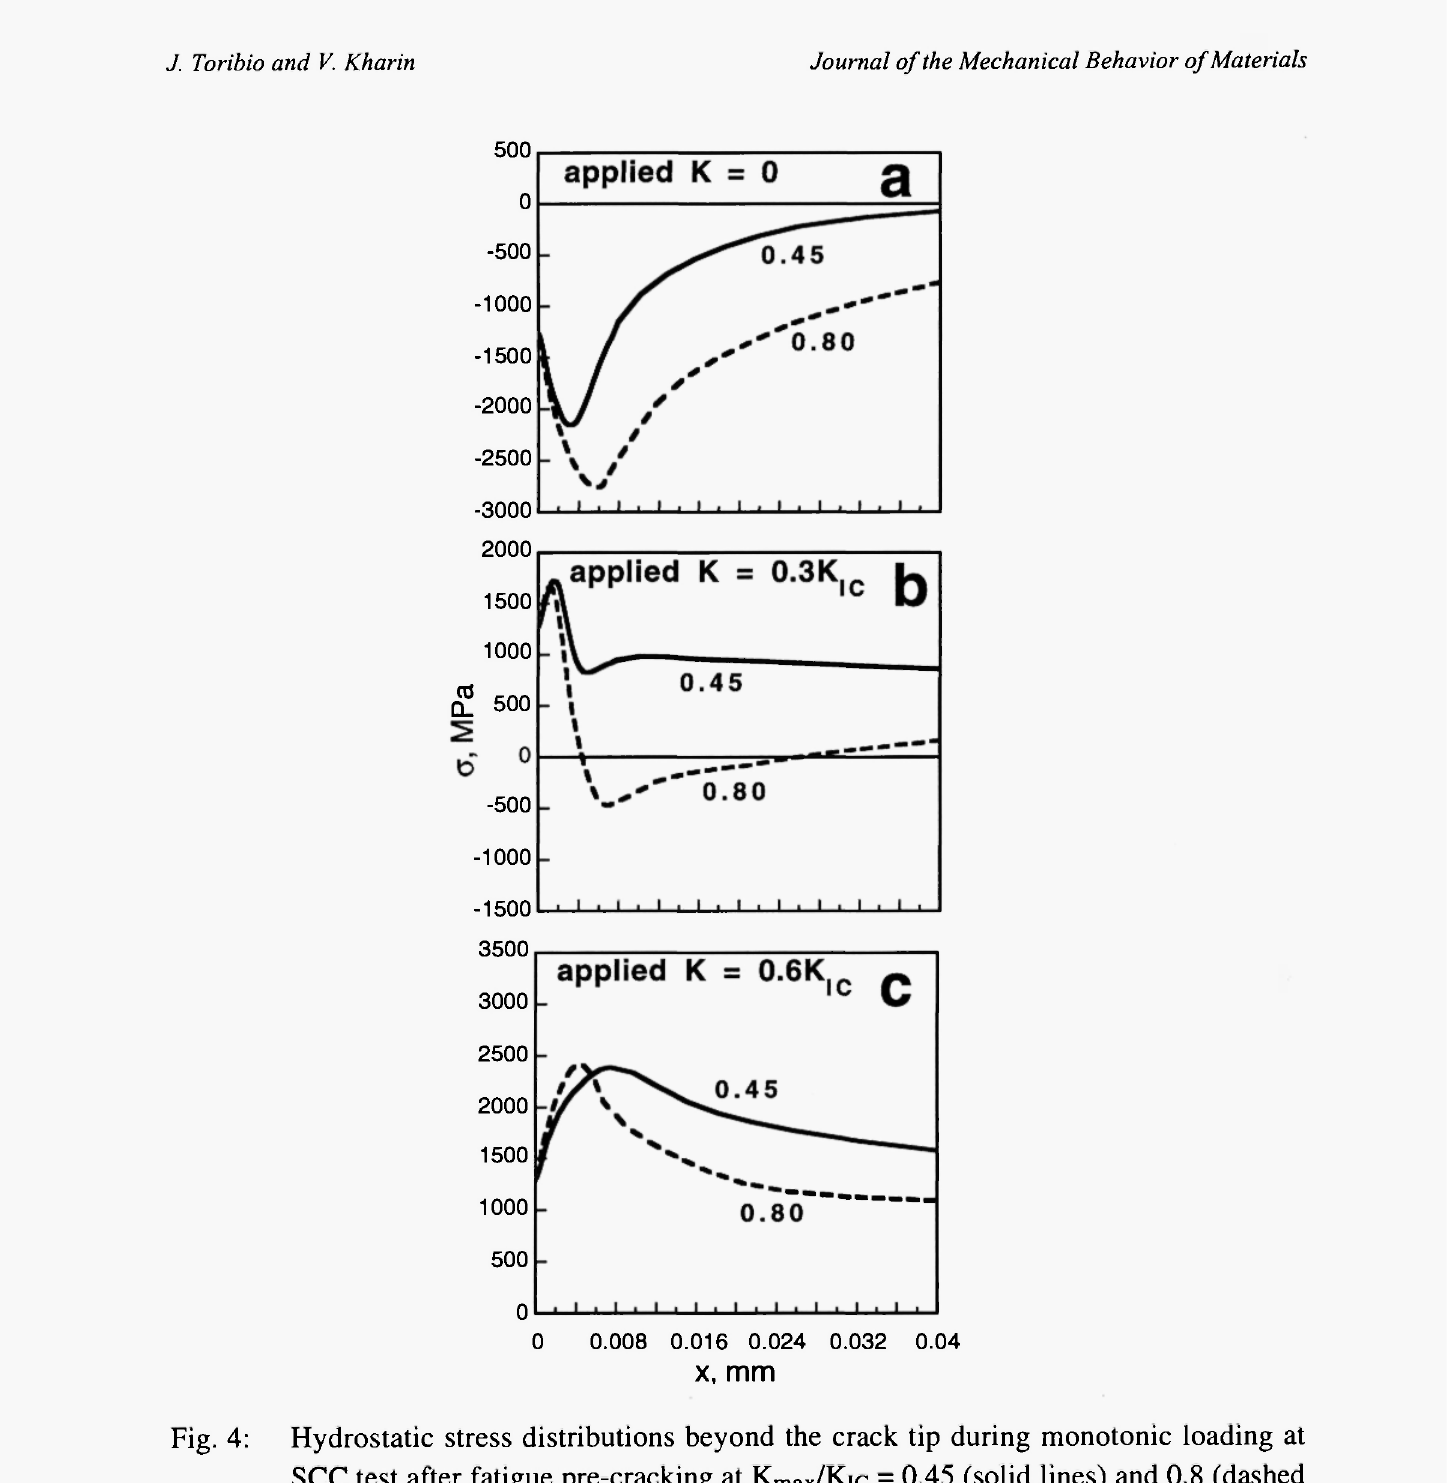
/Ki = 0.45 (solid lines) and 0.8 (dashed max C